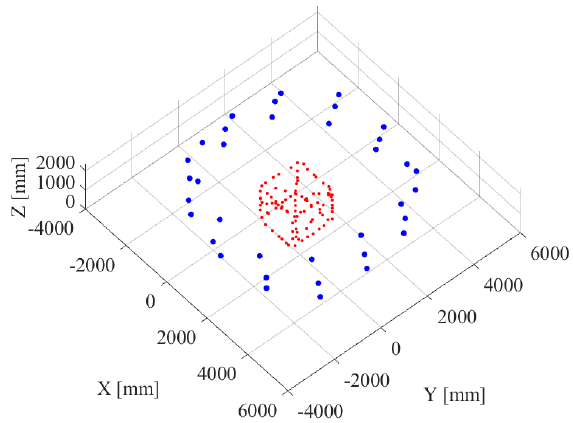
Figure 2. Setup of the synthetic dataset. Blue points indicate the positions of the camera, red points indicate the cubic arranged object points.